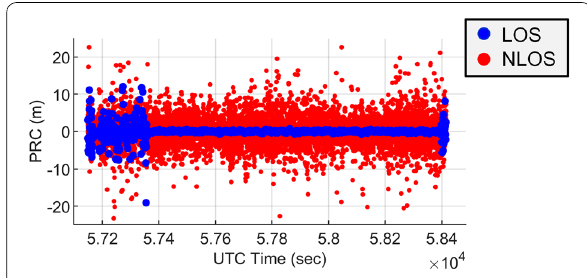
Fig. 6 Demonstration of NPR of LOS and NLOS in an urban